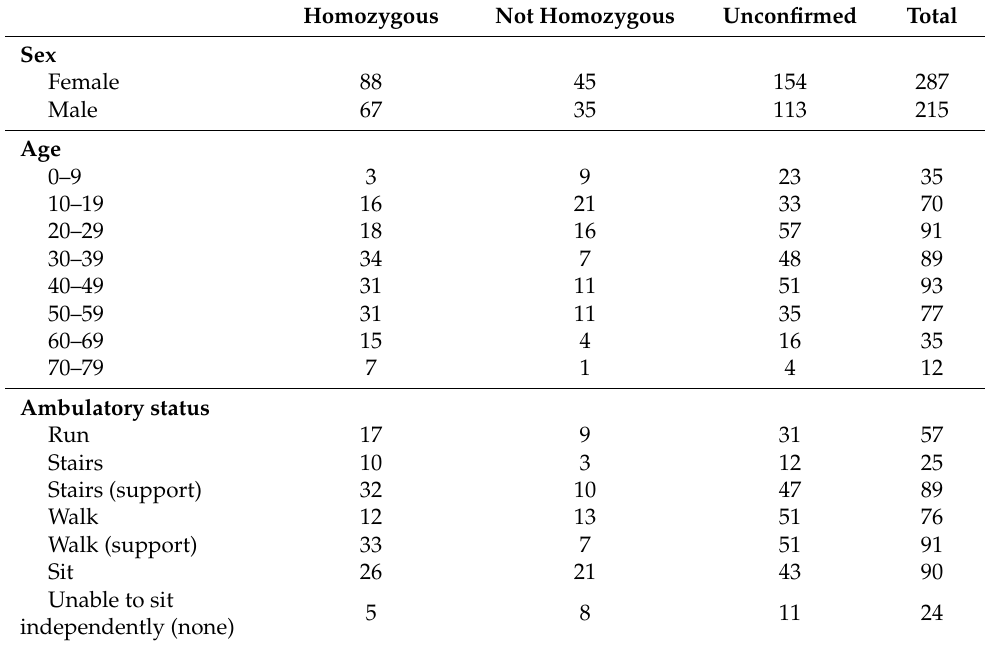
Table 1. Demographic